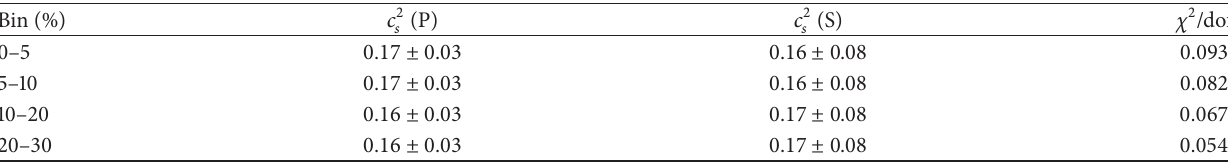
Table 3: Values of 𝑐 2 𝑠 for the participants and spectators as well as 𝜒 2 /dof for the curves in Figure 8 which represent Pb-Pb collisions at 2.76 TeV (LHC